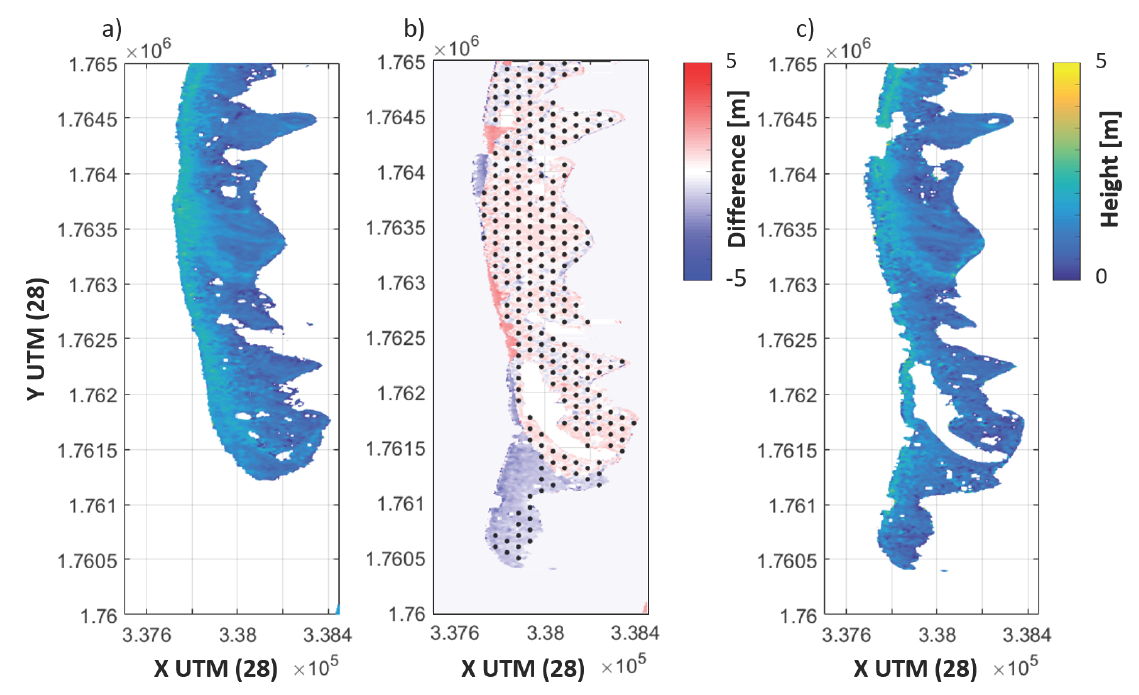
Figure 4. ( a ) Sand spit natural area morphology derived from Pleiades—March 2019. ( b ) DEMs difference (2020–2019) with stippled area represents the vertical change (<1 m). ( c ) Sand spit natural area morphology derived from